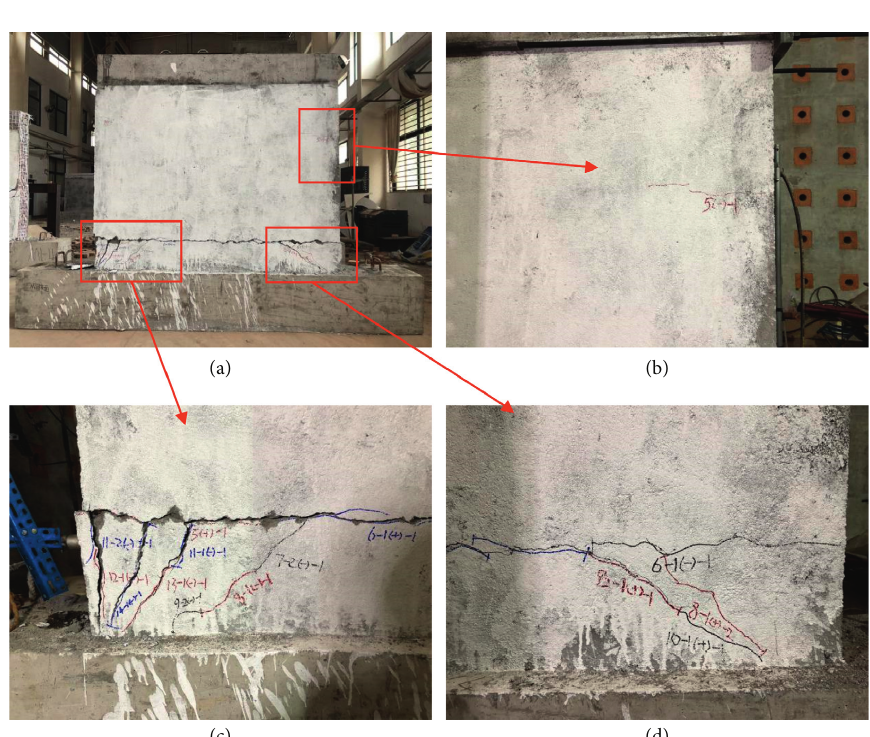
Figure 6: Damage mode of unstrengthened specimen W-1. (a) Overall damage, (b) local cracks, (c) damage in the bottom left corner, and (d) damage in the bottom right corner.